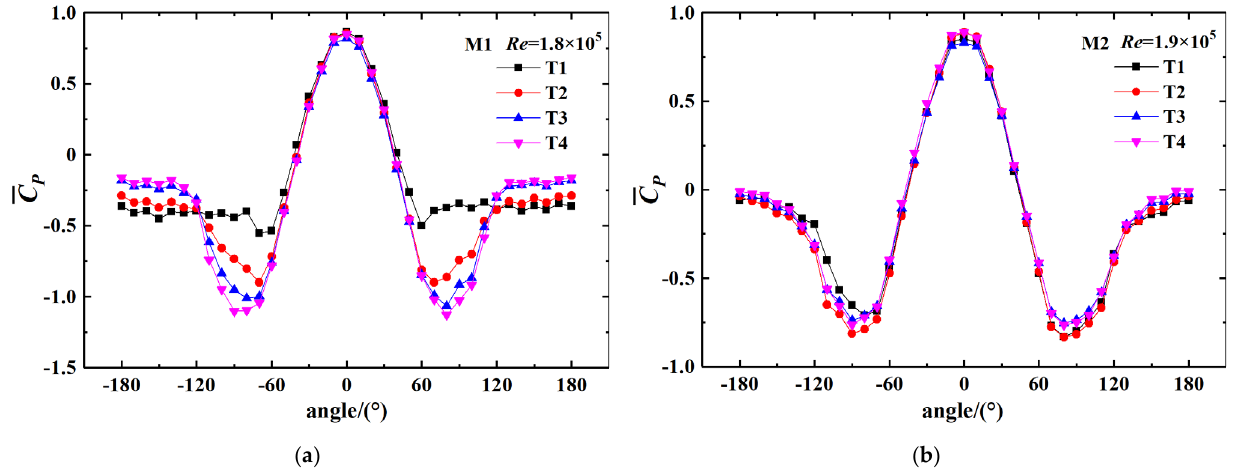
Figure 6. The distribution of the wind pressure coefficient at 0.5H of models under different wind fields. ( a ) M1; ( b ) M2.